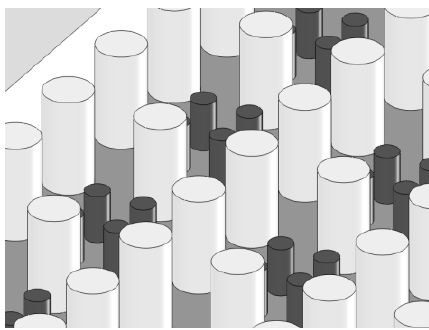
Fig. 9 The geometry of Type 2 ' (modified Type 2). A short pillar of Type 2 (see Fig. 2(c)) is divided into four pillars with halved diameter (dark circles). The PDMS surface area is increased, which causes enhancement in p is